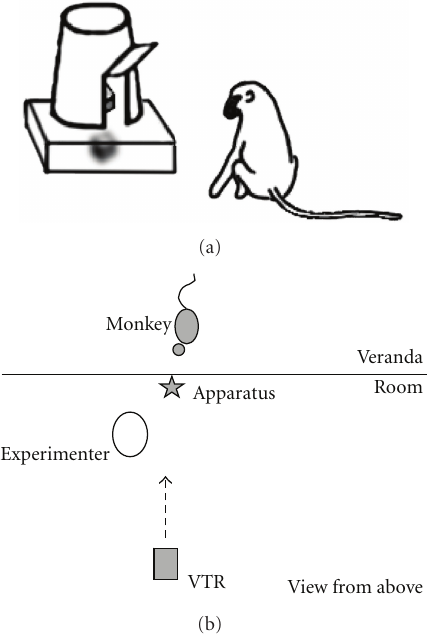
Figure 1: (a) Apparatus (not to scale). (b) Testing site (not to scale). tested them once a monkey sat down on the veranda facing the apparatus within 1 meter (for males) or 2 meters (for females) for 5 seconds. We applied di ff erent distance criteria to males and females because the males were more adventurous and approached closer to the apparatus than the females. The monkeys usually came to the testing site individually, but if two or more monkeys were present, the experiment was not carried out until only one monkey